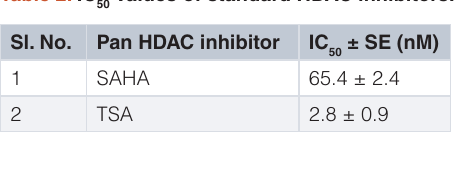
Table 3. Hos2 enzyme inhibition values of Class I HDAC inhibitor.